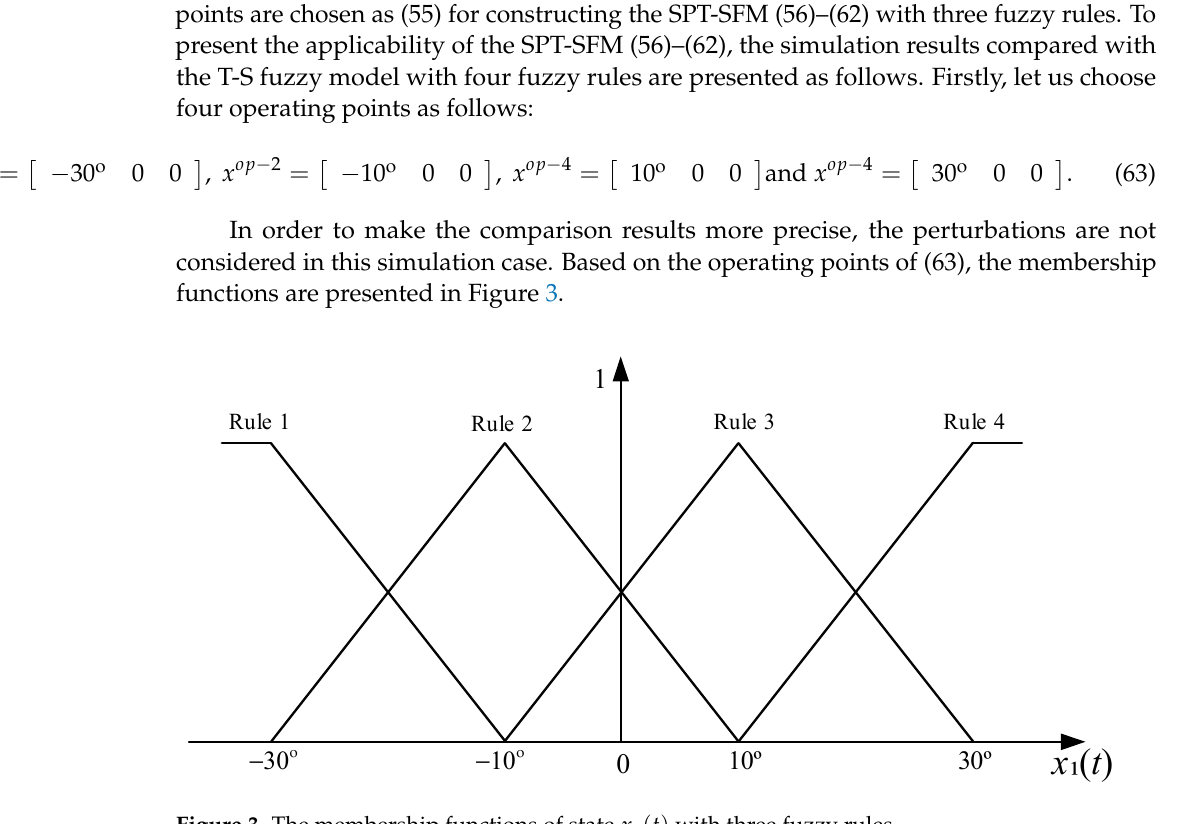
Figure 3. The membership functions of state ( ) Then, the SPT-SFM for the nonlinear synchronous generator system (46) with four fuzzy rules can be constructed as